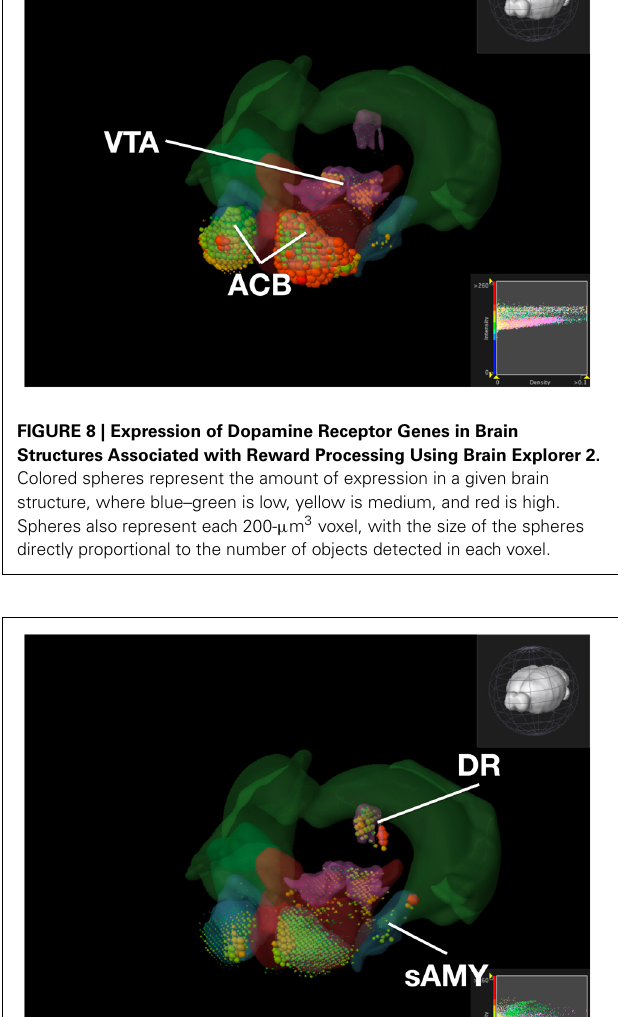
Another key difference between Brain Explorer and ABADV